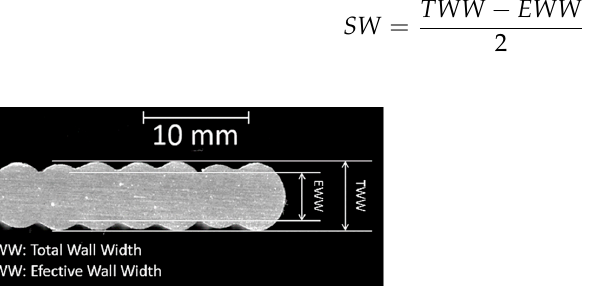
Figure 3. Geometrical features measured to characterize surface texture. During the building process, the heights of the preforms from the substrate at the 4th (PHL4) and 12th (PHL12) layers were measured with a Vernier caliper at the 50, 100, and 150 mm horizontal lengths. These average data were used to estimate the average LH as below (Equation (3)). The first 4 layers were disregarded to ensure that the process had already reached a steady-state regime.